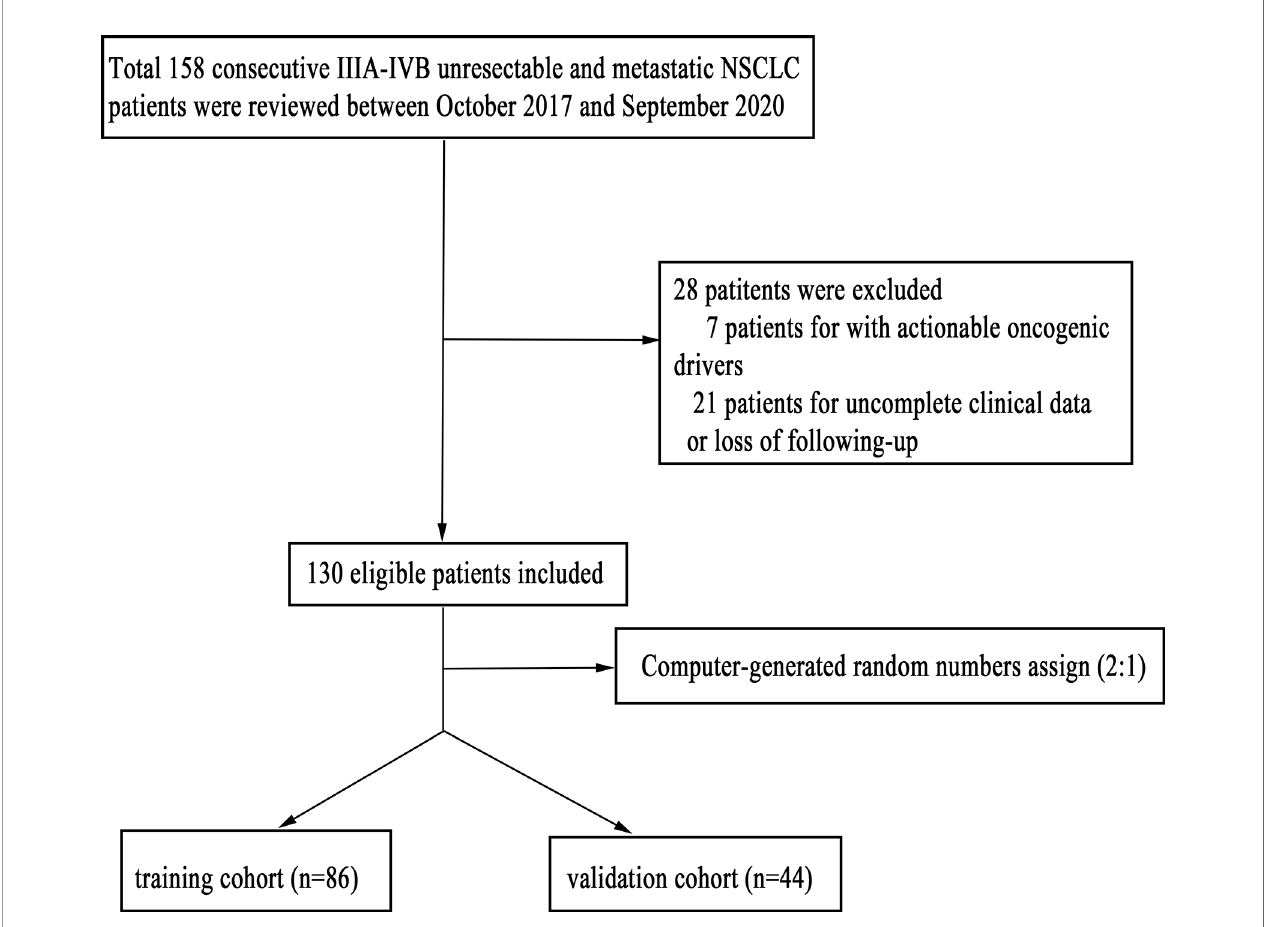
FIGURE 1 | The work fl ow of patient